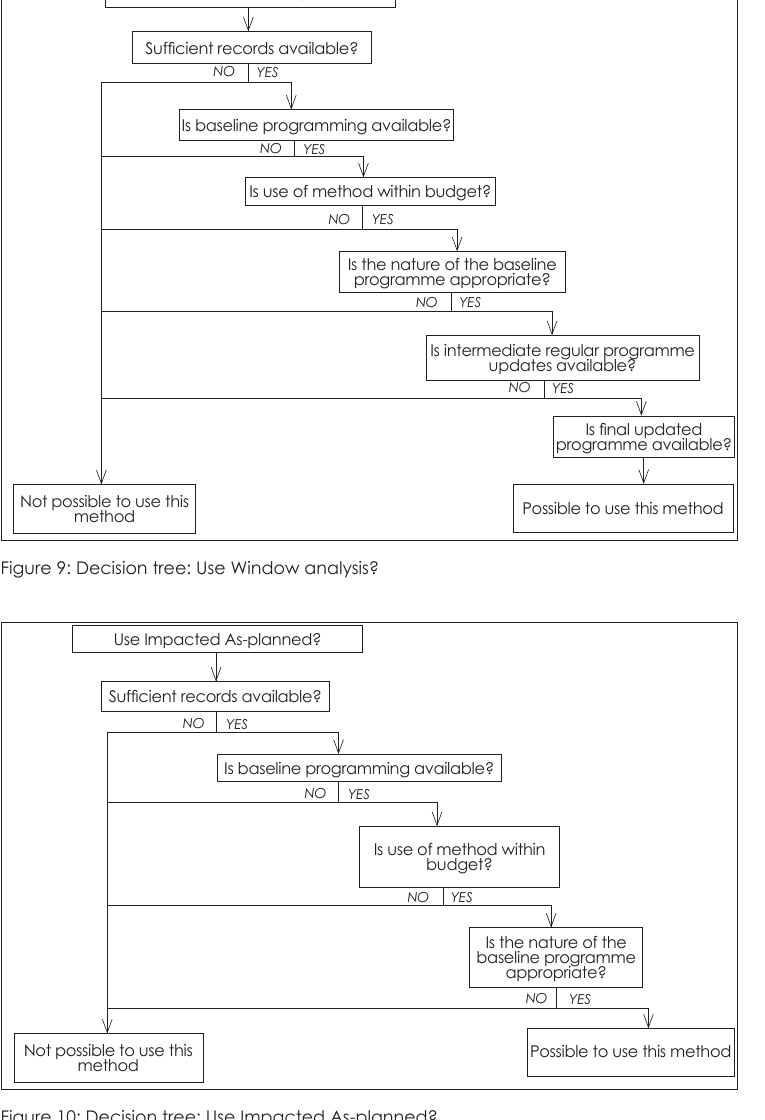
Figure 10: Decision tree: Use Impacted